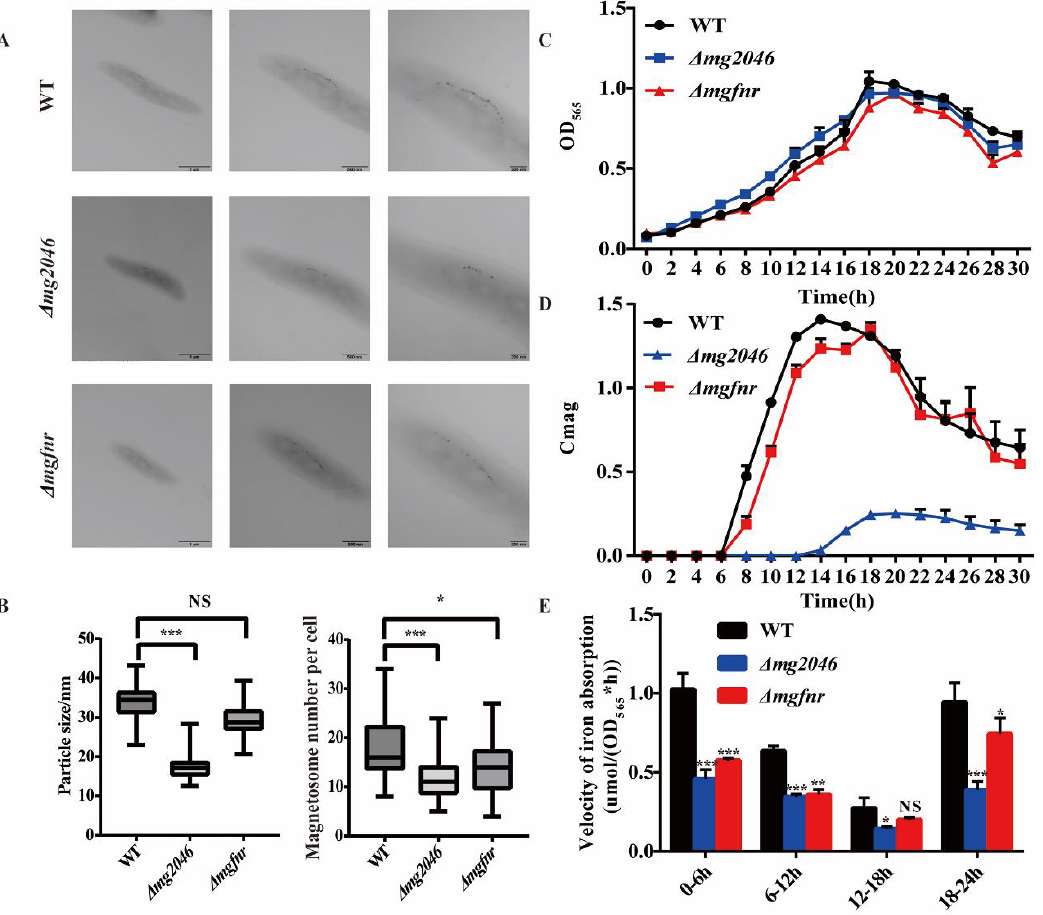
Figure 3. Phenotypic analyses of WT, Δmg2046 , and Δmgfnr . ( A ) TEM images with progressive enlargement from left to right. Scale bars: 1 µm, 500 nm, 200 nm. ( B ) Magnetosome particle size and number per cell. ( C ) Cell growth curve (OD 565 ). ( D ) Magnetic response (Cmag) curve. ( E ) Cellular iron absorption rate. Data shown represent mean ± SD from three replicates. NS: no significant difference ( t -test). * p < 0.05; ** p < 0.01; *** p < 0.001. Error bar: SD from three replicate experiments. MTB were cultured in a thermostatic shaker. For construction of the Cmag curve, vertical and horizontal magnetic fields were added by modifying the spectrophotometer, measuring absorbance, and calculating Cmag values to reflect differences in number and maturity of magnetosomes. OD 565 growth curves of Δmgfnr / Δmg2046 were similar to that of WT (Figure 3C). Comparison of Cmag curves showed that magnetosome synthesis in Δmg2046 began at 12 h and that Cmag value was significantly lower than that of WT, indicating slower magnetosome synthesis and reduced mag- netic response. The magnetic response curve of WT was similar to that of Δmgfnr, indicating that absence of mgfnr did not strongly affect magnetosome synthesis (Figure 3D). Iron absorption rates were calculated at 6-h intervals, based on measurement of residual iron content in cells. Rates for Δmg2046 / Δmgfnr were lower than for WT over various time periods. Rates for Δmgfnr were higher